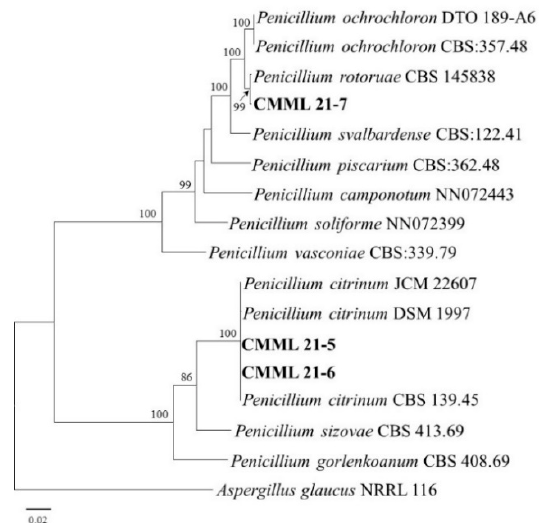
Figure 4. Maximum likelihood tree of the Penicillium isolates (CMML21–5, CMML21–6, and CMML21–7) constructed from the combined data sets of the ITS, RPB2, CAL, and BT gene sequences constructed by the MEGA X program. The tree is rooted to Aspergillus glaucus NRRL 116. Numbers on the branches indicate the bootstrap values. The scale bar indicates expected changes per site. The isolates from the present study are indicated in bold.